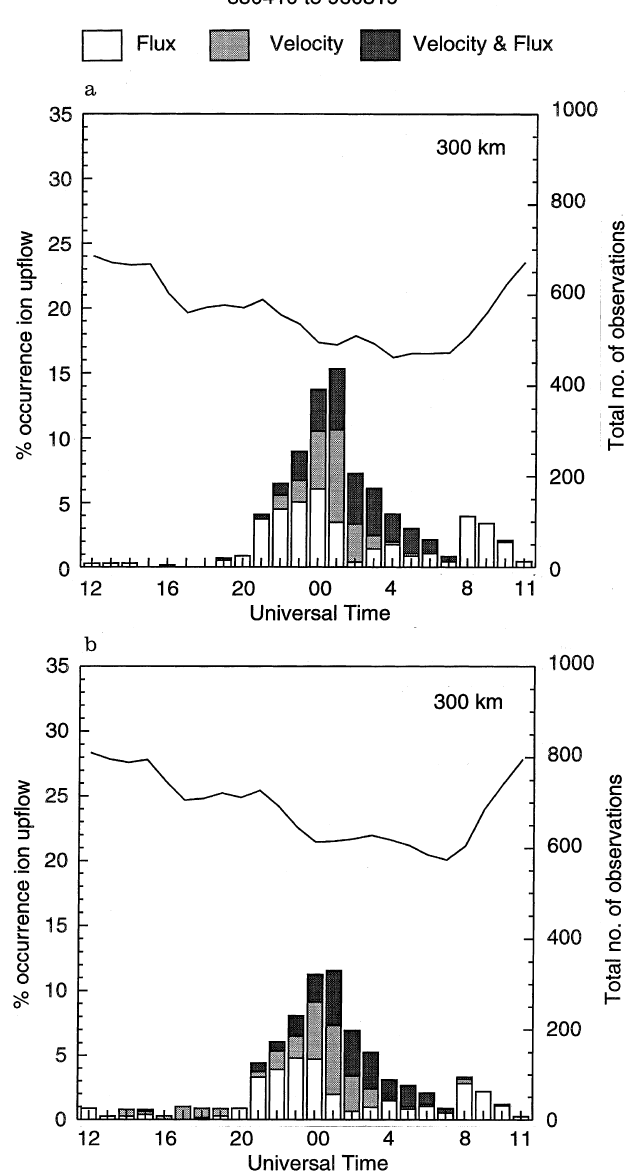
Fig. 4. a Diurnal distribution of vertical upflows derived from vertical velocities calculated from CP-2 tristatic measurements of v b Diurnal distribution of upflows derived from CP-2